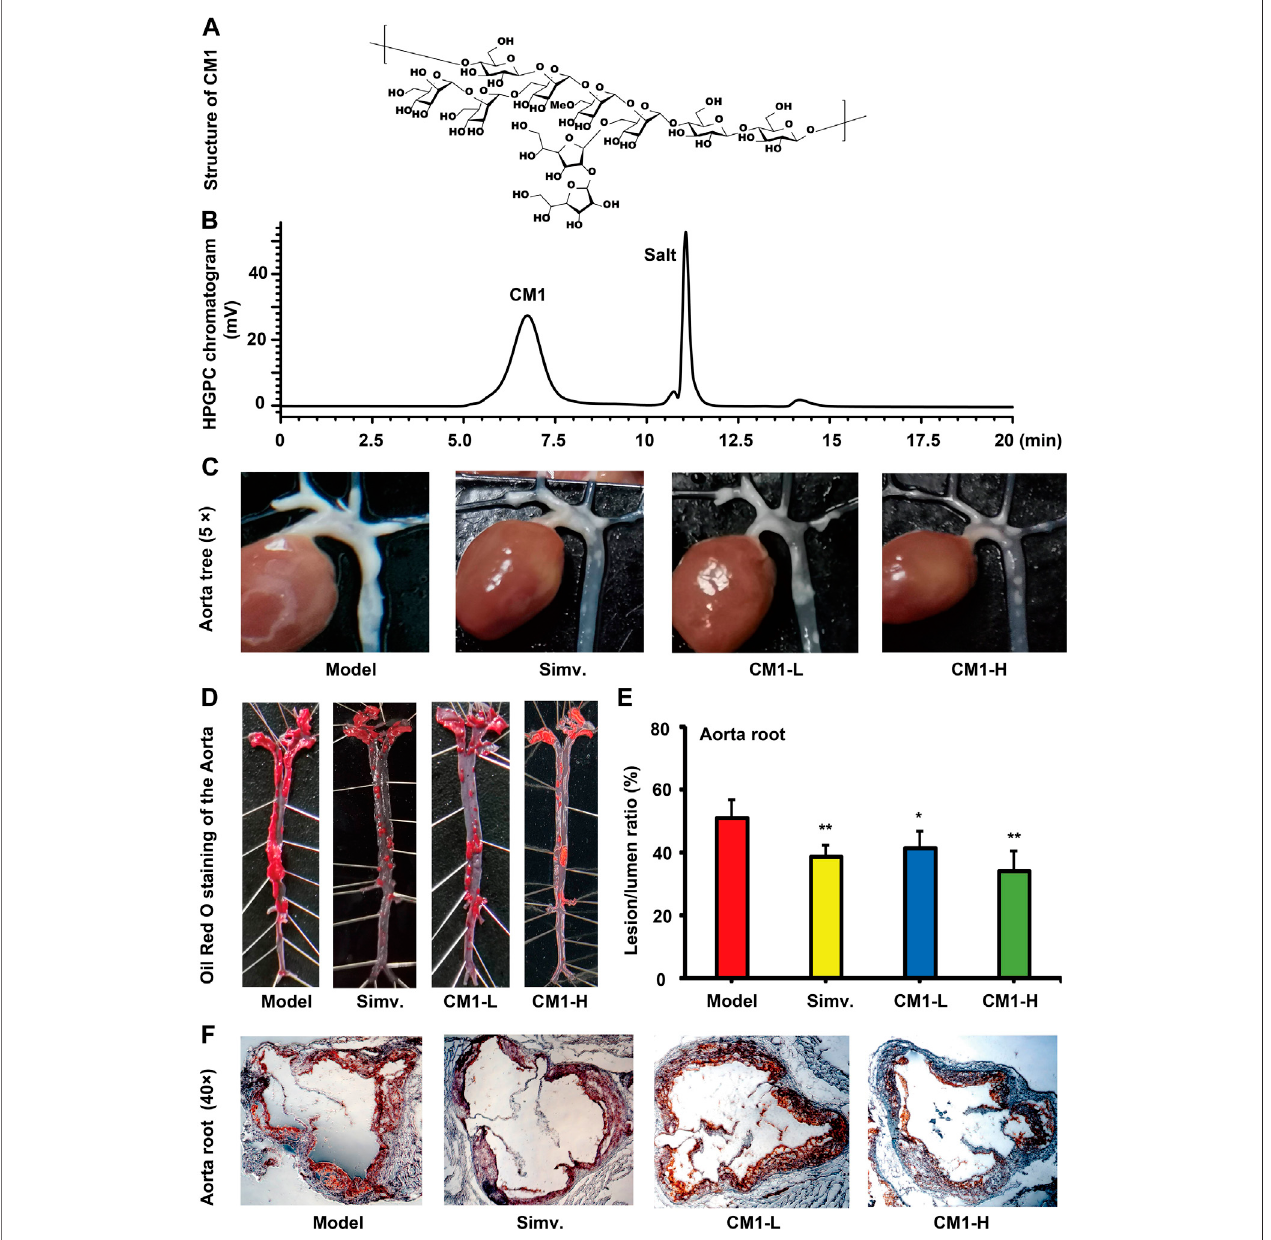
FIGURE 1 | Structure and effect of polysaccharide CM1 on the formation of atherosclerotic plaques in the LDLR (-/-) mice ( n ≥ 6). (A) , structure of CM1; (B) , elution curve of CM1 on a TOSOH TSKgel G5000PWXL column (7.8 mm × 300 mm); (C) , representative images of the aortic tree; (D) , representative images of whole aorta after Oil Red O staining; (E) , statistical analysis of the lesion/lumen ratio in the aorta root; (F) , representative cross-sectional lesions of the aorta root. Data are presented as mean ± SD. Blank: chow diet group; Model: high-fat and – cholesterol diet group; Simv.: simvastatin; CM1-L: LDLR (-/-) mice treated with CM1 at the dose of 25 mg/kg/d;CM1-H:LDLR (-/-) micetreatedwithCM1atthedoseof100 mg/kg/d.*means p < 0.05 vs .Model,and**means p < 0.01 vs .Model.Alltheabbreviationsare applied for the rest of the fi